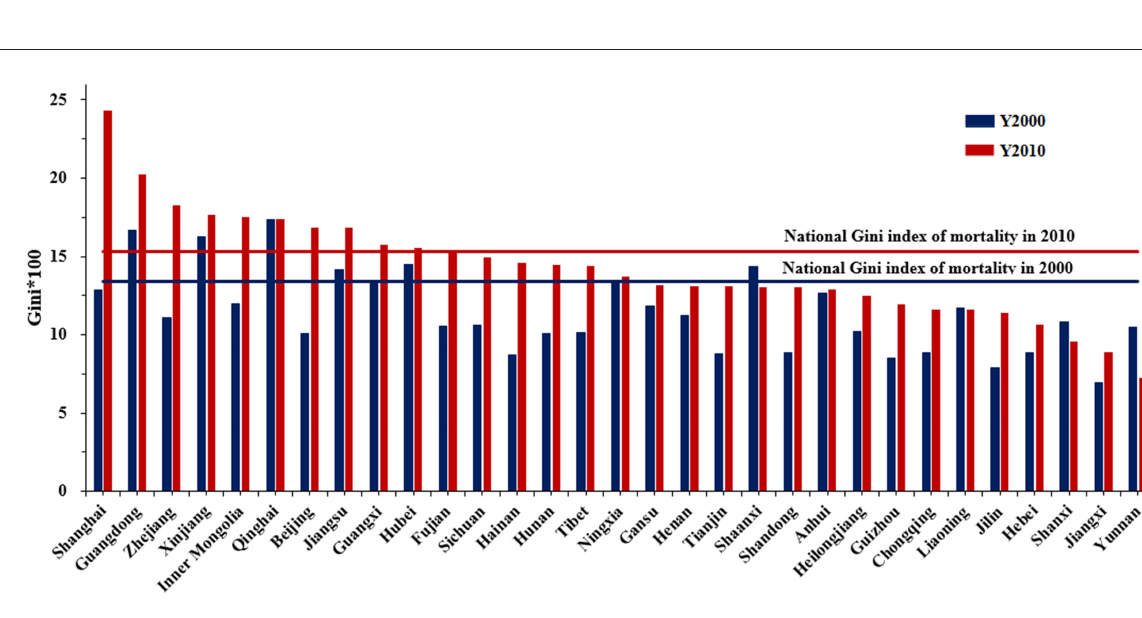
FIGURE2 Gini index of mortality within provincial administrative unit for 2000 and